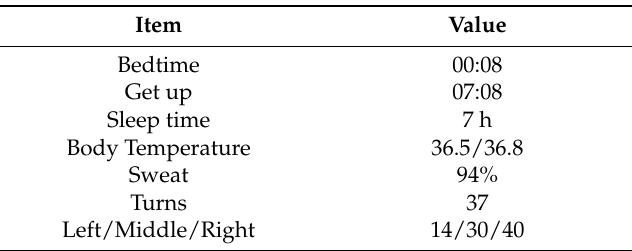
Table 3. Daily report for sample